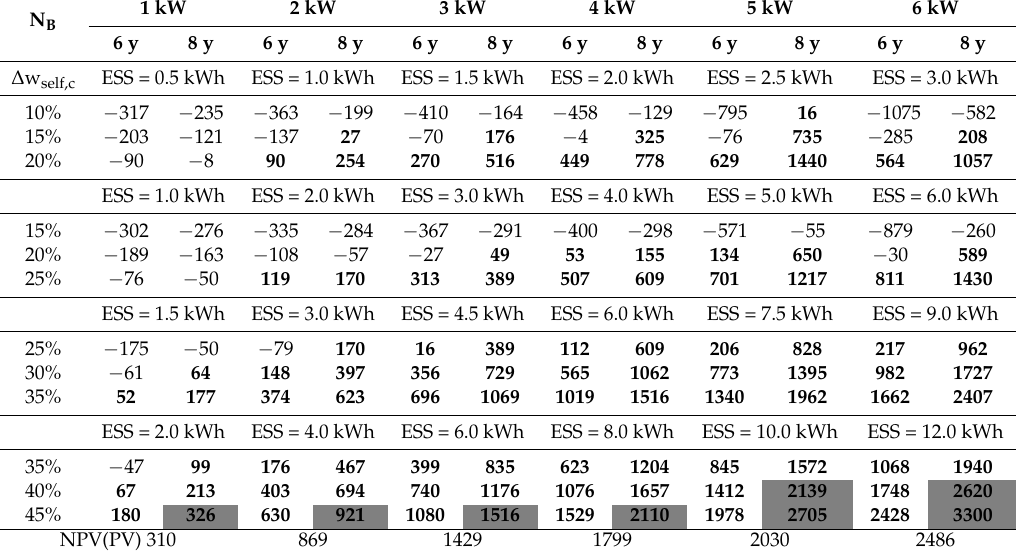
Table 5. Net Present Value ( € ) of integrated PV-battery systems without regional subsidies. N